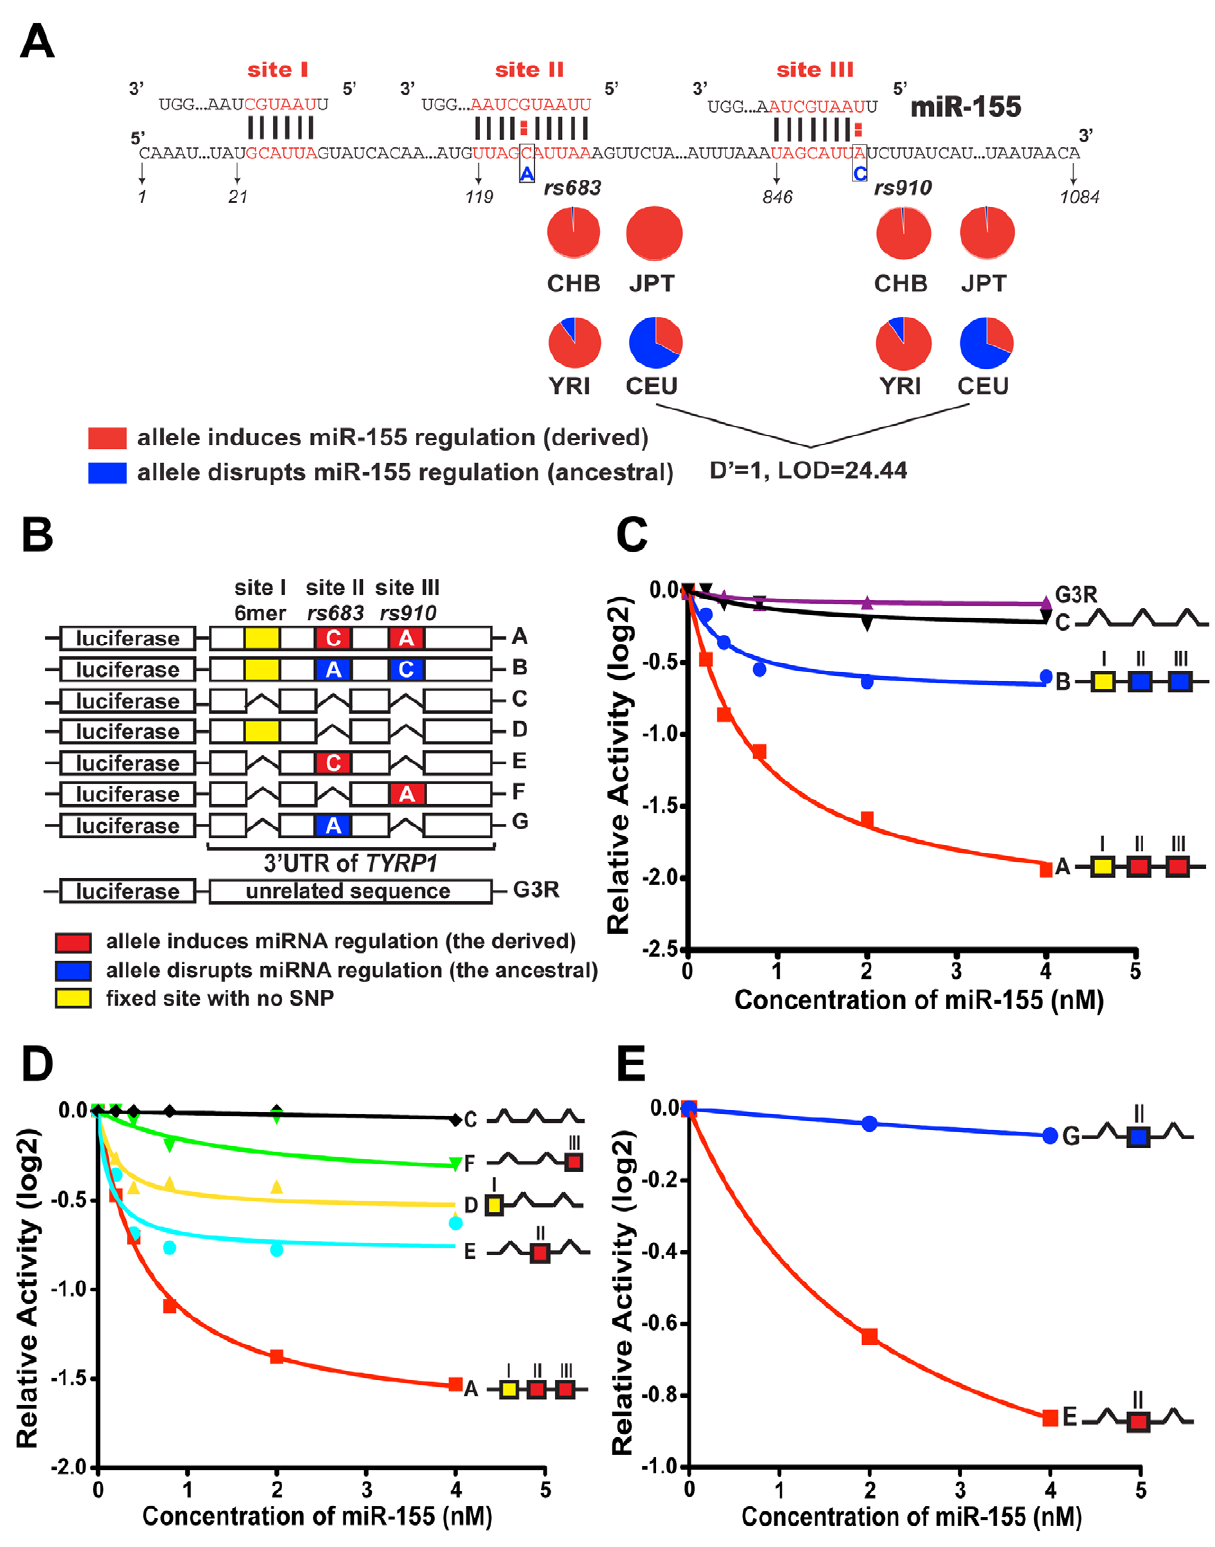
Figure 2. Modulation of miR-155 regulation of TYRP1 by rs683 and rs910. (A) 3 9 UTR sequences of TYRP1 , which harbors 3 predicted miR-155 binding sites (site I, II and III). Site I had been fixed in all populations, mediating a 6-mer match to miR-155. The positions of SNPs rs683 and rs910 in sites II and III are shown with ancestral allele in blue and derived allele in red. The pie charts show the distribution of ancestral and derived alleles in CEU, CHB, JPT and YRI. Note that the derived alleles are almost fixed in CHB, JPT and YRI, but are highly polymorphic in CEU. (B–D) Effects of rs683 and rs910 on miR-155 regulation using luciferase reporters. Luciferase reporter constructs (shown in B) were individually transfected into HEK293T cells together with either miR-CTL or increasing concentrations of miR-155 as indicated. The luciferase expression in cell lysates was then measured by